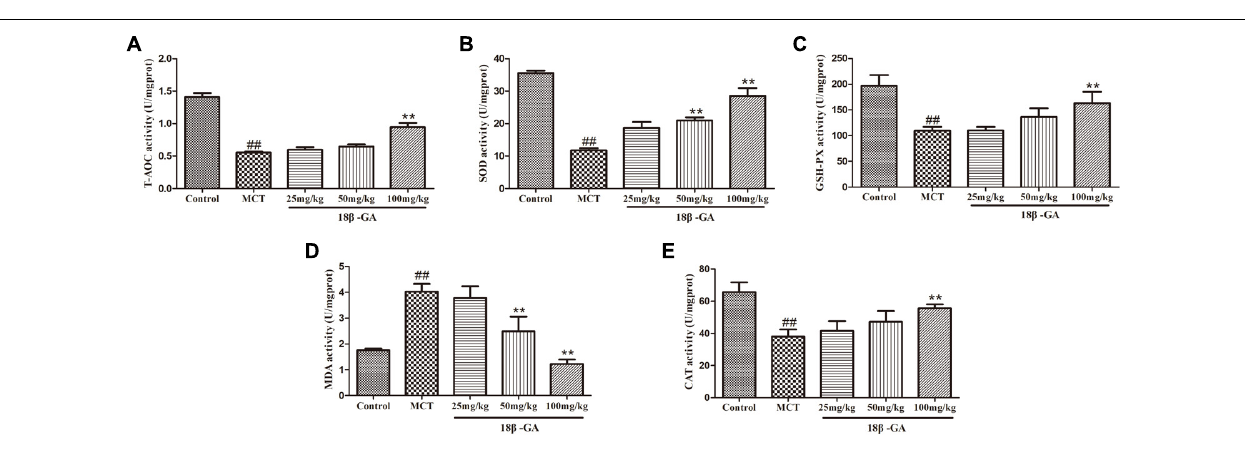
FIGURE 8 | Effect of 18 β -glycyrrhetinic acid on oxidative stress induced by MCT. (A) Effect of 18 β -glycyrrhetinic acid on T-AOC expression. (B) Effect of 18 β -glycyrrhetinic acid on SOD expression. (C) Effect of 18 β -glycyrrhetinic acid on GSH-PX expression. (D) Effect of 18 β -glycyrrhetinic acid on MDA expression. (E) Effect of 18 β -glycyrrhetinic acid on CAT expression. Data are expressed as mean ± SEM ( n = 10). ## p < 0.01 vs. control group, ∗∗ p < 0.01 vs. MCT group. T-AOC, total antioxidant capacity; SOD, determine superoxide dismutase; GSH-PX, glutathione peroxidase; MDA, malonyldialdehyde; CAT, catalase; MCT, monocrotaline; 18 β -GA, 18 β -glycyrrhetinic